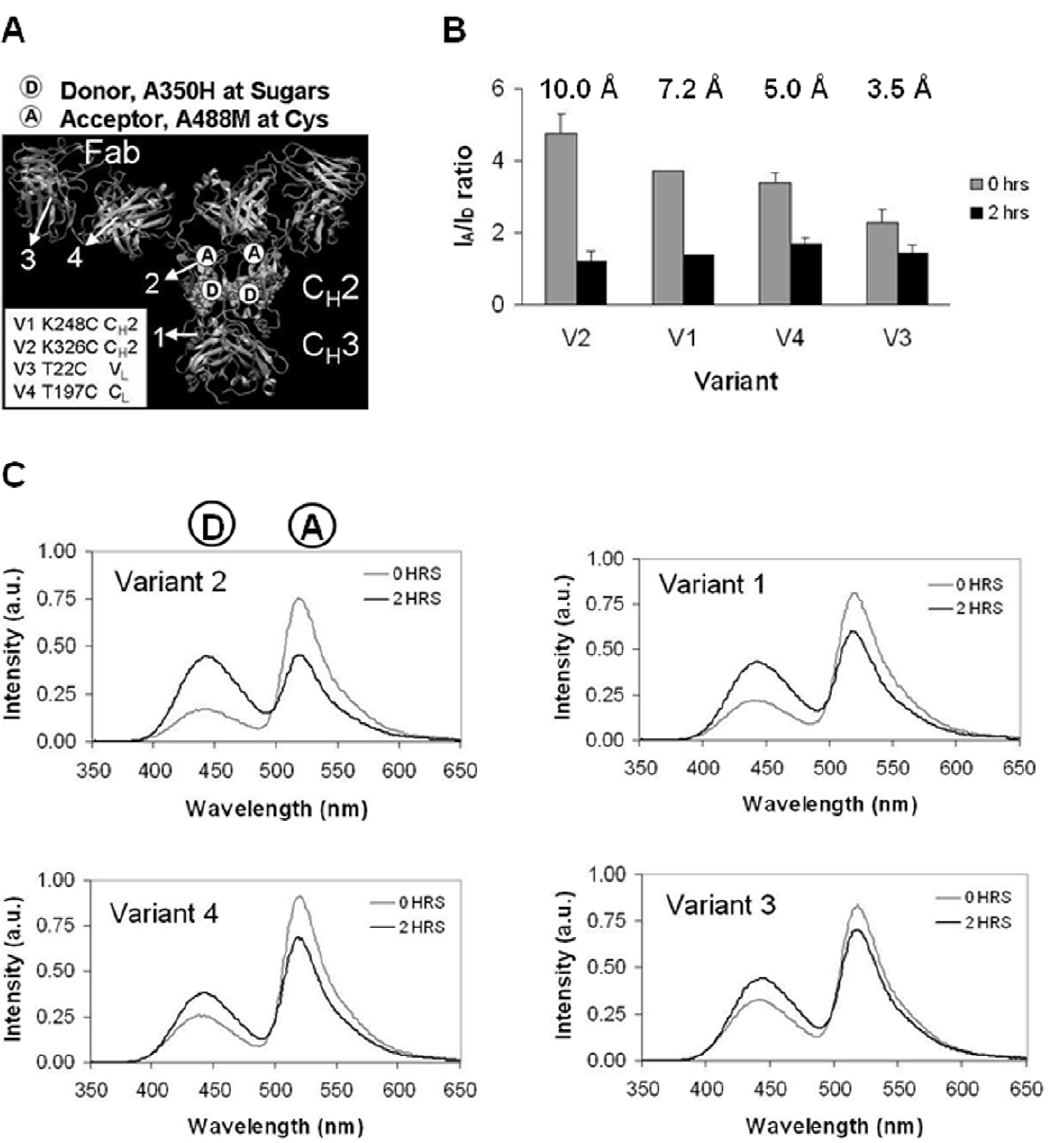
Figure 2. Peptide-carbohydrate interactions are disrupted upon heat stress. (A) a full-antibody cartoon illustrates the positions of the variants with engineered surface cysteines, and labeling approach in this set of experiments. Carbohydrates were labeled with Alexa350 hydrazide dye. Surface cysteines for each variant were labeled with Alexa488 maleimide dye. Variants 2 and 1 have surface cysteines engineered in the C H 2 domain, and Variants 4 and 3 in the Fab region. (B) Ratiometric analysis of fluorescence data for double-labeled samples after heat stress at 60 u C for 2 hours. Acceptor/donor ratios of stressed (2 hrs) and unstressed (0 hrs) samples are shown. The number above each pair of columns indicates the change in distance between the donor and acceptor fluorophores in the initial and final state. (C) Steady-state fluorescence data for individual double-labeled variants.